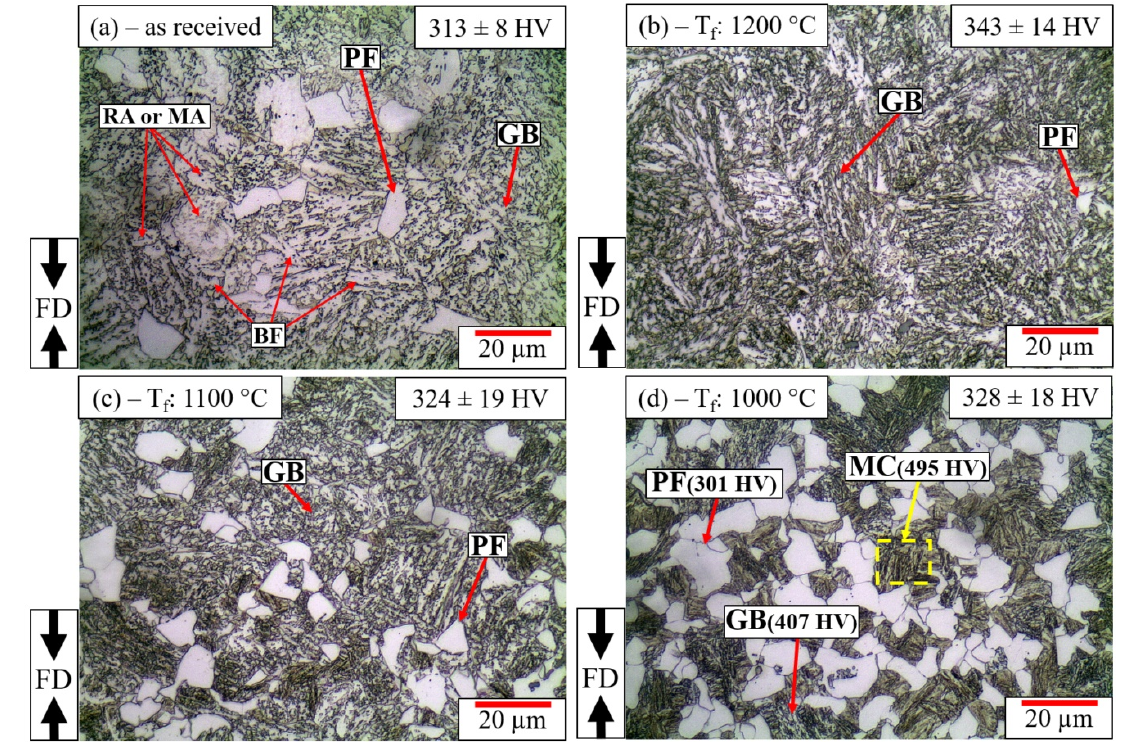
Figure 6. Optical microscopy of ( a ) as-received condition and forged samples cooled in calm air: ( b ) forged at 1200 ◦ C; ( c ) forged at 1100 ◦ C; and ( d ) forged at 1000 ◦ C. PF, polygonal ferrite; GB, granular bainite; MC, third microconstituent; RA, retained austenite; MA, martensite / austenite; BF, bainitic Ferrite; FD, forging direction.